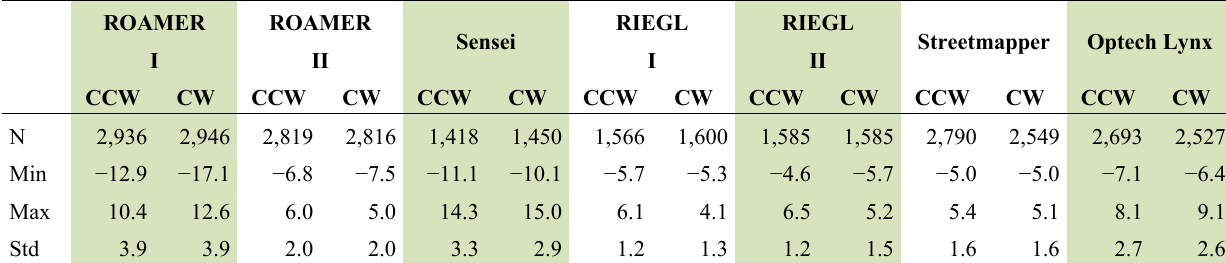
Table 3. The elevation accuracy values, in cm, for the tested MLS systems. Driving directions: counter-clockwise CCW and clockwise CW. N is the number of used reference points.